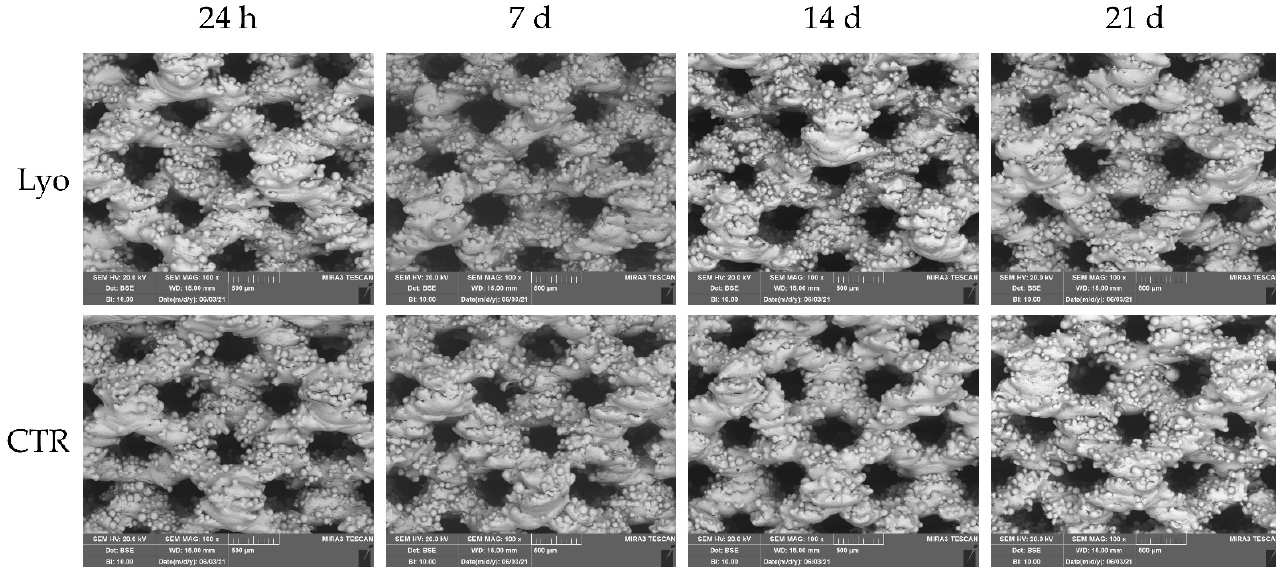
Figure 2. SEM morphological and structural characterizations of Ti cages seeded with MSCs and cultured in osteogenic medium with Lyosecretome or without (CTR). Images were acquired in backscattering mode to show the distribution of various elements that constitute the sample. The brighter regions reveal high-density materials (Ti) and the shaded areas indicate low-density materials (organic material). Magnification 100×. Scale bar: 500 µm.